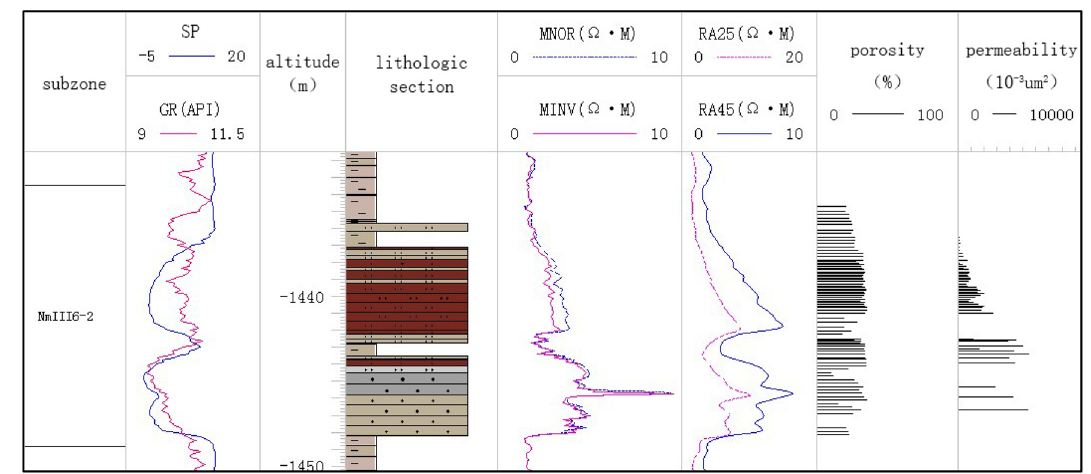
Fig. 13 Well log response curve of lateral accumulation mudstone in well Gang225